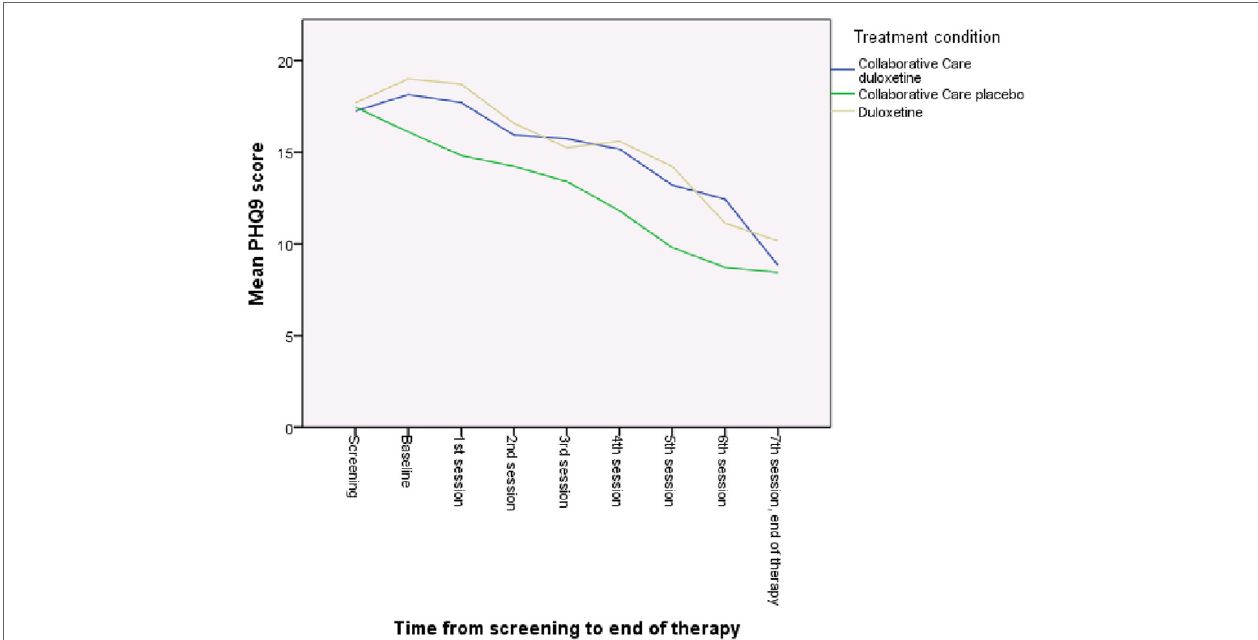
FigUrE 3 | Mean Patient Health Questionnaire 9 (PHQ9) score of the three treatment groups over time.